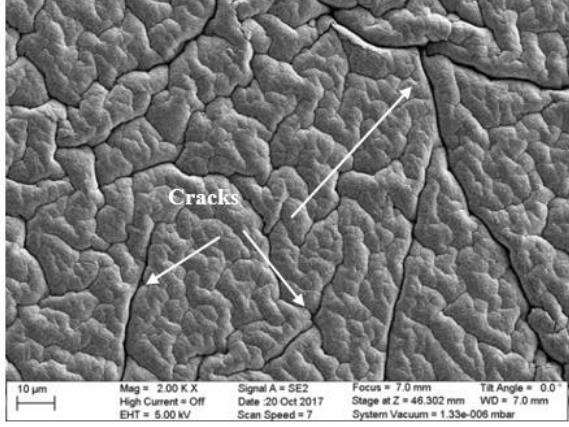
Figure 4. Scanning electron microscope (SEM) image of ZnO film.